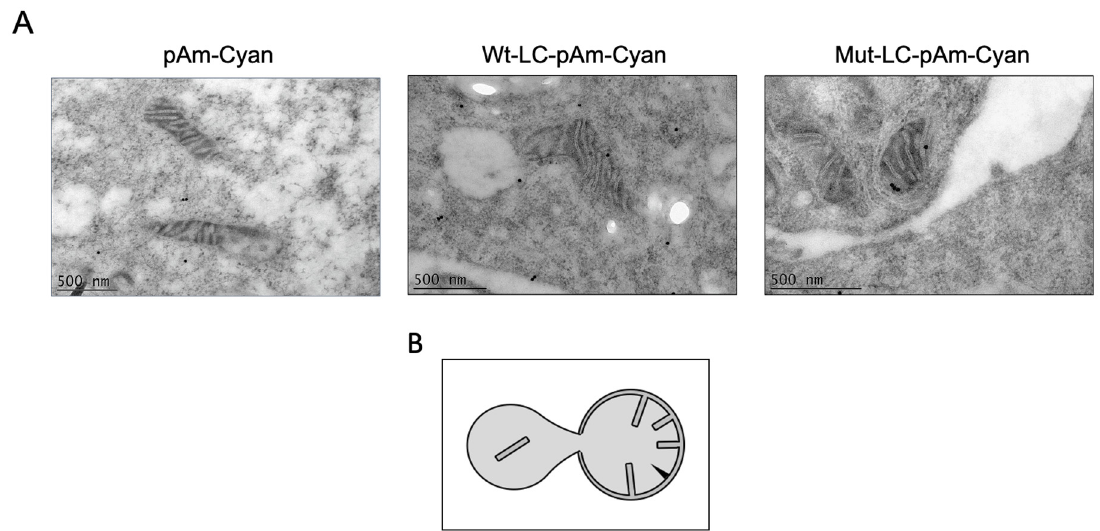
Figure 6. WT-LC, but not mutant-LC-C40A proteins, could induce internal membrane herniation in mitochondria. ( A ) Transmission electron microscopy images of the mitochondria integrity from CrFK cells transfected with pAm-Cyan (upper panel), Wt-LC-pAm-Cyan (center), or Mut-LC-pAm-Cyan (lower panel). After 24 h of transfection, cells were fixed and processed for TEM and immunogold labelling. ( B ) Schematic of apoptotic mitochondrial profile first reported in [33].